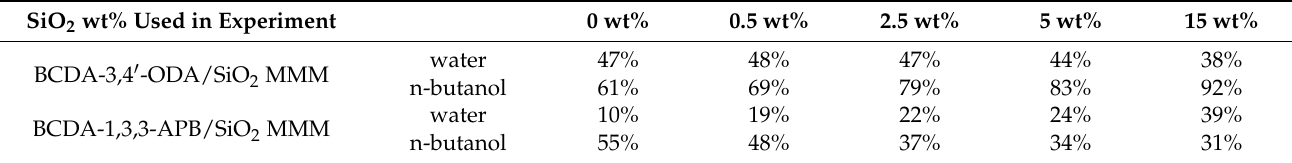
Table 4. Degrees of swelling for pristine alicyclic PI membranes and their related PI/SiO 2 mixed matrix membranes. SiO 2 wt% Used in Experiment 0 wt% 0.5 wt% 2.5 wt% 5 wt% 15 wt% BCDA-3,4 (cid:48) -ODA/SiO 2